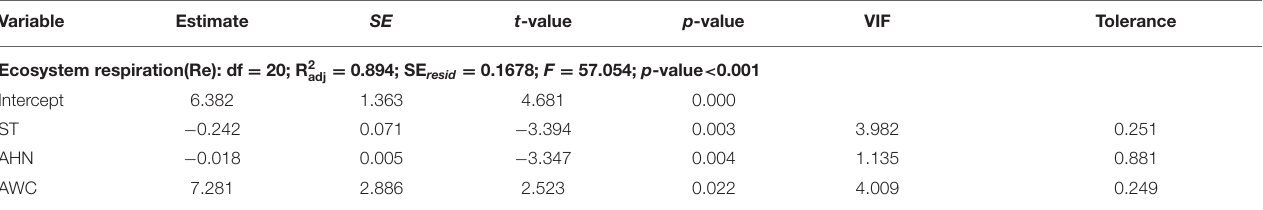
TABLE 3 | Summary of the results of multiple linear stepwise regression analysis of the effects of environmental factors on ecosystem respiration (Re).